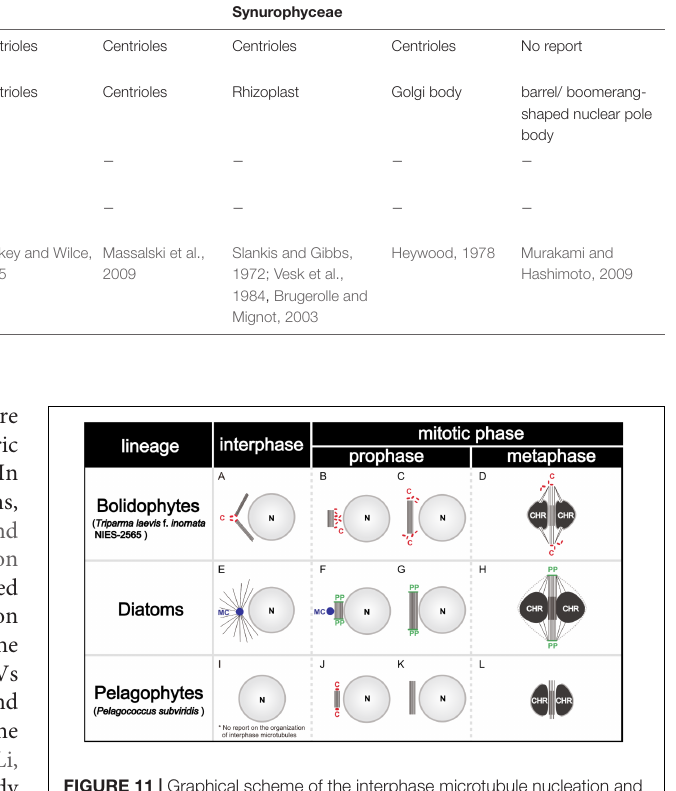
FIGURE 11 | Graphical scheme of the interphase microtubule nucleation and the spindle formation in bolidophytes (A–D) , diatoms (E–H) , and pelagophytes (I–L) . See text for details. Figures (A–D) and (E–H) are adapted from Yamada et al. (2017) and De Martino et al. (2009) with